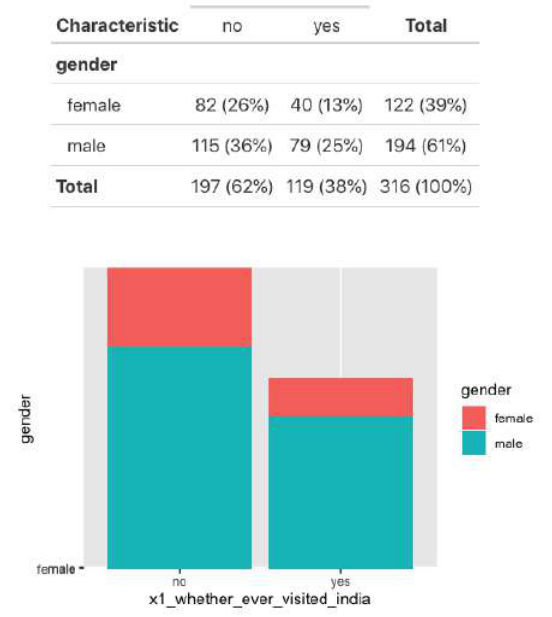
Figure 6: Whether ever visited India? (Source: Authors‟ depiction ) Table 6: Whether ever visited countries other than India? (Source: Authors‟ depiction